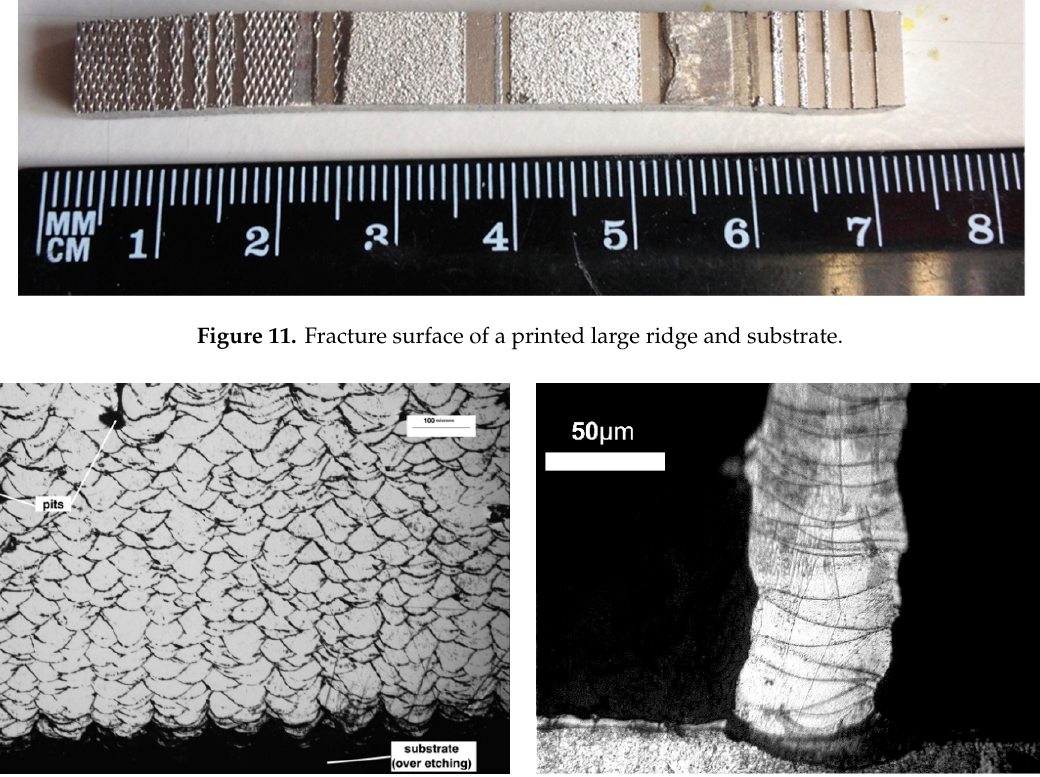
Figure 12. Cross-section of micro features printed by SLM.